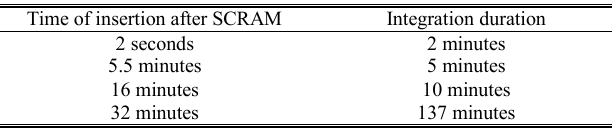
TABLE III C HARACTERISTICS OF THE DELAYED MEASUREMENTS WITH TLD